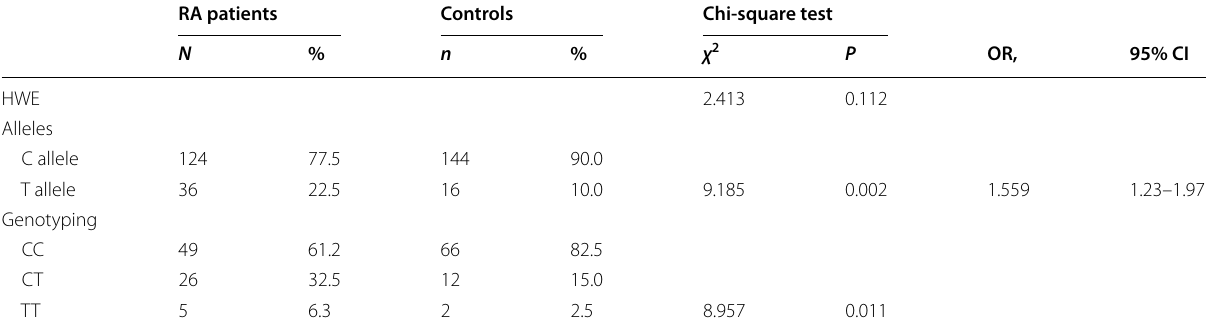
Level of significance at P